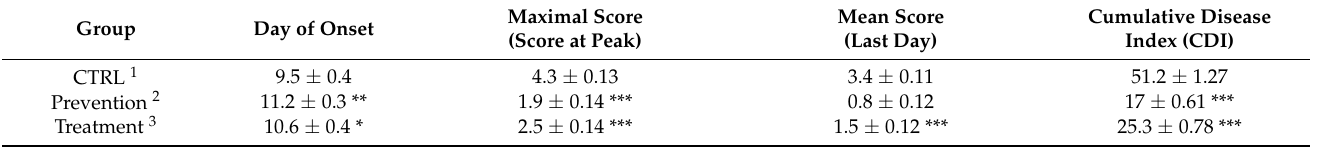
Table 2. Clinical features of EAE in the administration of MOG, both as prevention and